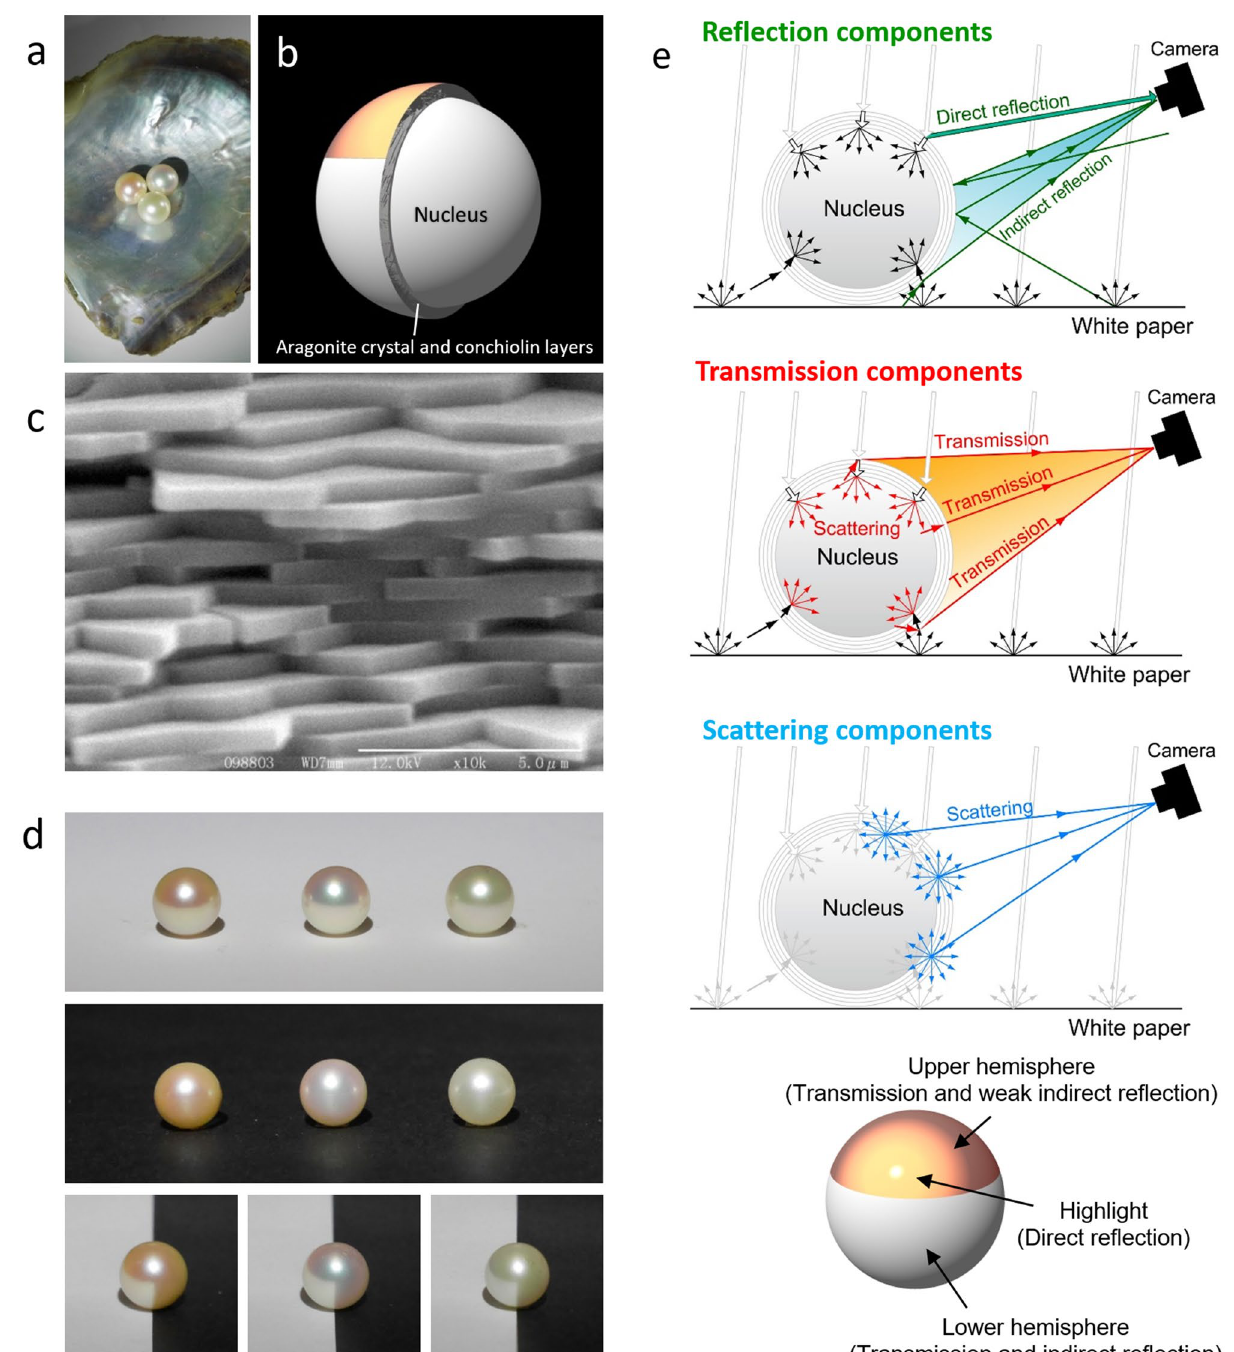
Figure 1. Structure, appearance, and optical model of pearls. ( a ) Three Akoya pearls of different colors. ( b ) Schematic illustration of structure of Akoya pearl. ( c ) SEM image of typical nacre of Akoya pearl. The length of the scale bar is 5 μm. ( d ) Photographs of three pearls placed on white and black sheets of paper. ( e ) Optical model for reflection, transmission, and scattering components of of a pearl using an integrating sphere, in which incident light from an LED enters the entire surface of a pearl except for the detector position (Fig. 2b). We consider that the system is suitable for measuring the transmission characteristics of pearls and verifying of the proposed transmission model (Fig. 1e). In the reflection spectra of the orange, pink-green, and green pearls (Fig. 2c–e), broad reflection bands show peaks corresponding to the center wavelength of multiple reflections from the aragonite crystal layers in nacre. The center wavelength λ m of the reflection band for a normal incidence is given by λ m = 2( n 1 d 1 + n 2 d 2 )/ m , where n 1 and n 2 are the refractive indices of the aragonite crystal and conchiolin layers, d 1 and d 2 are the thicknesses of the aragonite crystal and